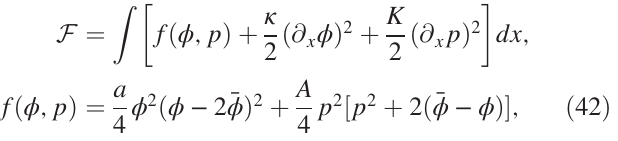
ffiffiffiffiffiffiffiffiffiffiffiffiffiffiffiffiffiffiffiffiffiffiffiffiffiffiffiffi p 1 þ A= ð 2 a ¯ ϕ 2 Þ